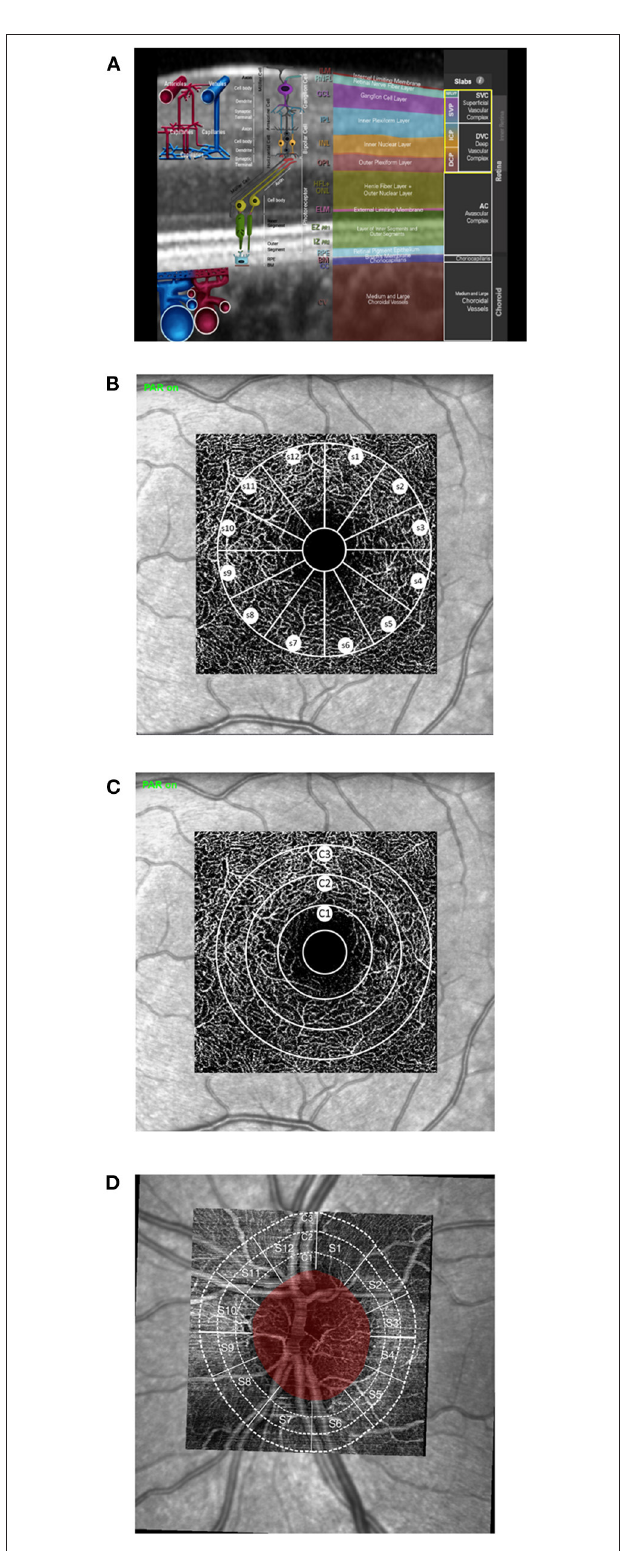
FIGURE 1 | Morphometric and quantitative analyses of optical coherence tomography angiography (OCT-A): (A) anatomic correlation of retinal layers to superficial capillary plexus (SVP), intermediate capillary plexus (ICP), and deep